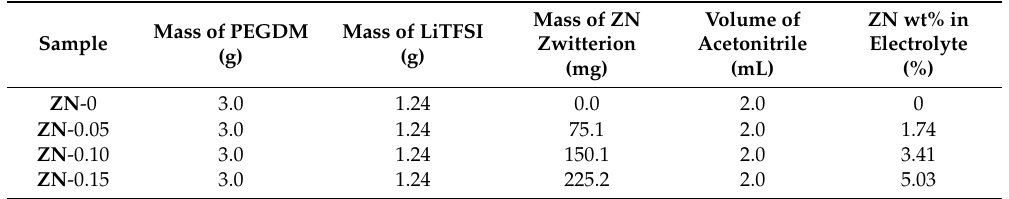
Table 1. Experimental data used for the preparation of electrolytes.